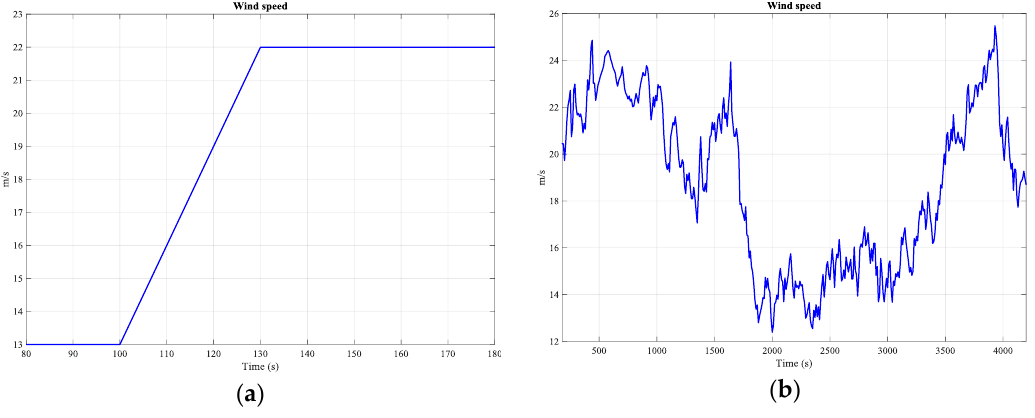
Figure 8. ( a ) Wind speed ramp; ( b ) wind speed time series.